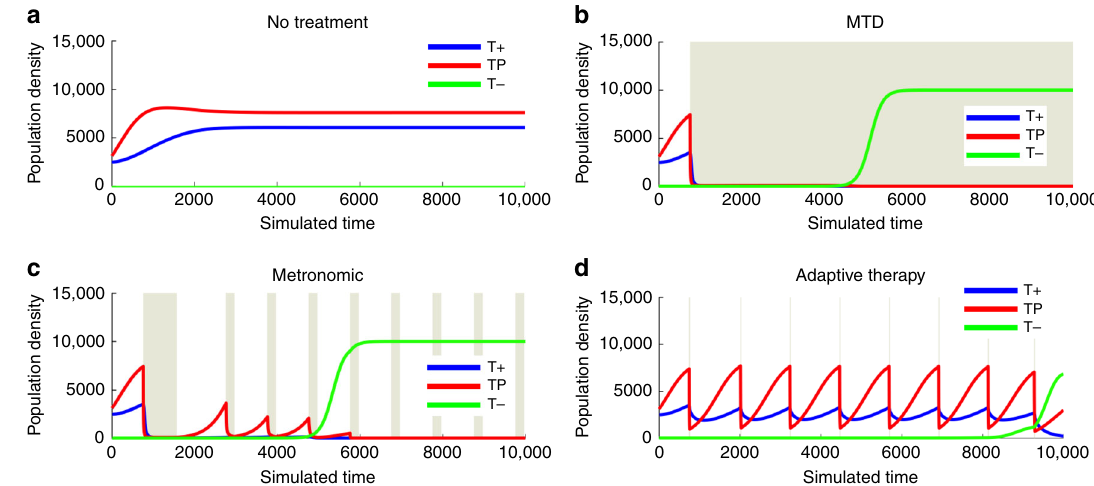
Fig. 2 Simulation results. Computer simulations of mCRPC growth during conventional maximum tolerated dose, metronomic, and adaptive application of abiraterone where the gray background indicates administration of abiraterone in Patient #1. a shows underlying population dynamics of a tumor if left untreated. b shows continuous application of abiraterone resulting in competitive release of T − cells and tumor progression. c panel shows a metronomic therapy similar to ADT intermittent therapy study where the lengthy induction period and further abiraterone is given at predetermined intervals. This shows that the bene fi t gained from adaptive therapies is not just the decrease in drug dosage but is indeed the evolutionary guided timing of the cycles. d shows a short administration of abiraterone decreasing the TP and T+ cells. However, abiraterone is discontinued when the PSA falls below 50% of the pretreatment value (Fig. 3). This permits recovery of TP and T+ cells, reverses the increase in T − cells, and prevents competitive release. After each treatment cycle, the tumor subpopulations remain nearly identical in size and